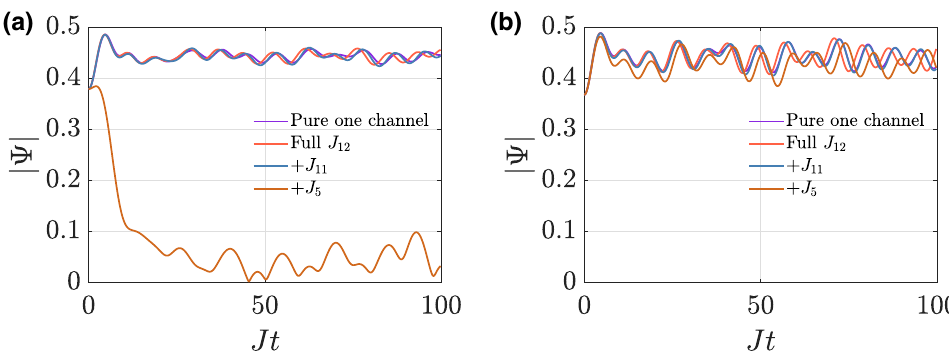
FIG. 5. Impact of off-resonant interactions on the one-channel model dynamics for crystals formed under two different trapping parameters: (a) case A and (b) case B (see Appendix B 1). In both cases, we progressively add terms to the pure one-channel model and study their impact. We add the following terms in the specified order: Chiral spin exchange by all modes ( J 12 ), antichiral spin exchange by all modes ( J 11 ), and achiral spin exchange by all modes ( J 5 ). Here, we start from a BCS-like initial state [top panel of Fig. 2(a)] and use the experimental parameters discussed in Appendix B. We have used B 1 ≈ J , where the value of J /( 2 π) ≈ 405